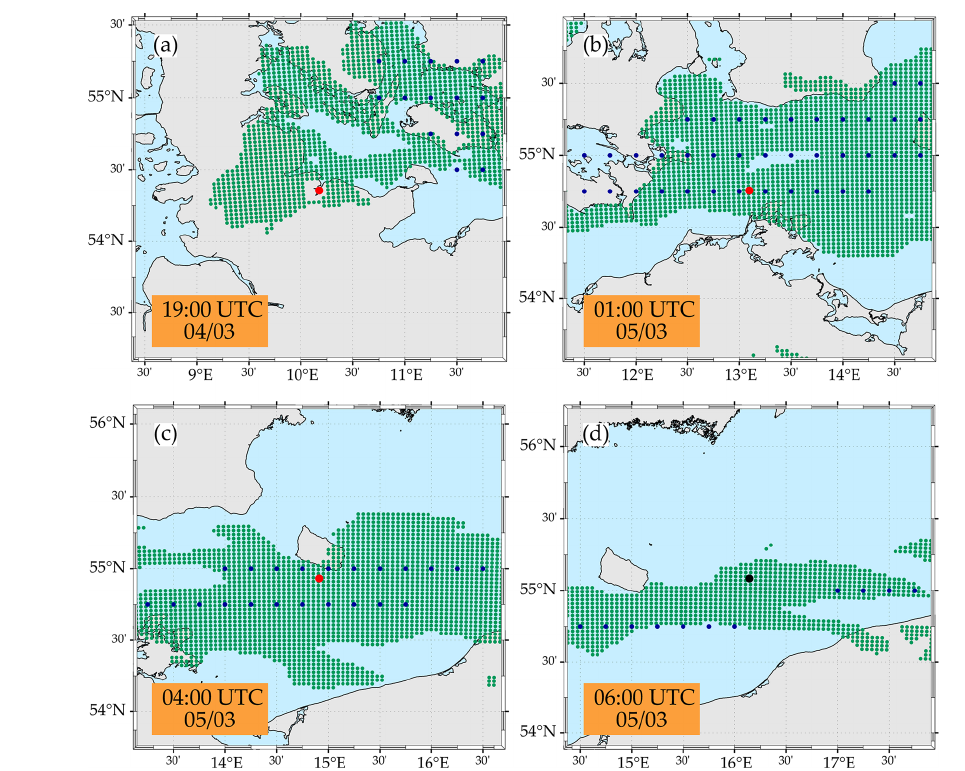
Figure 16. ERA5 and NEWA grid points where an LLJ is detected at the indicated times. Vessel position is marked with a black dot if, according to the lidar measurements, no LLJ is present at the corresponding timestamp and red in case of an LLJ